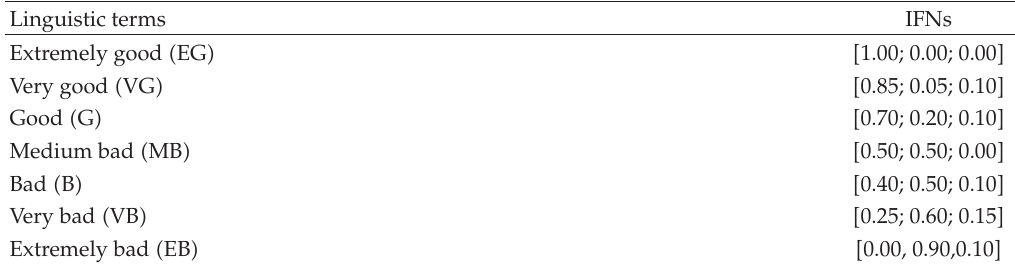
Table 3: Linguistic terms for rating the